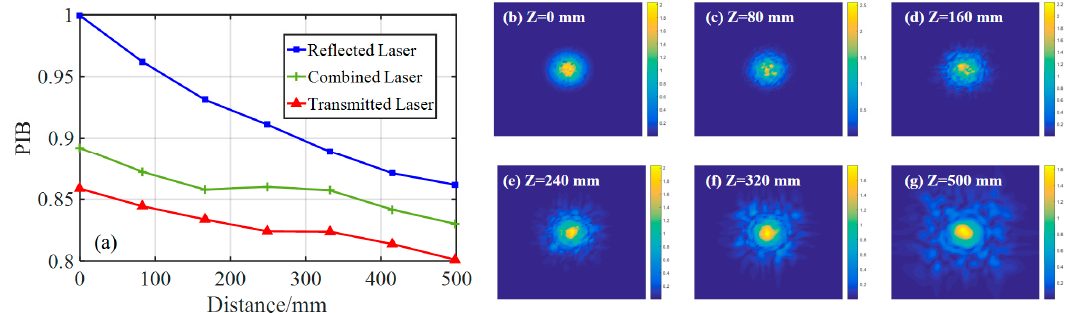
Figure 10. ( a ) The encircled power versus the propagation distance, with a surface roughness of 2 nm. The intensity profiles of the combined beam at different propagation distances Z ; ( b ) Z = 0 mm; ( c ) Z = 80 mm; ( d ) Z = 160 mm; ( e ) Z = 240 mm; ( f ) Z = 320 mm; ( g ) Z = 500 mm.